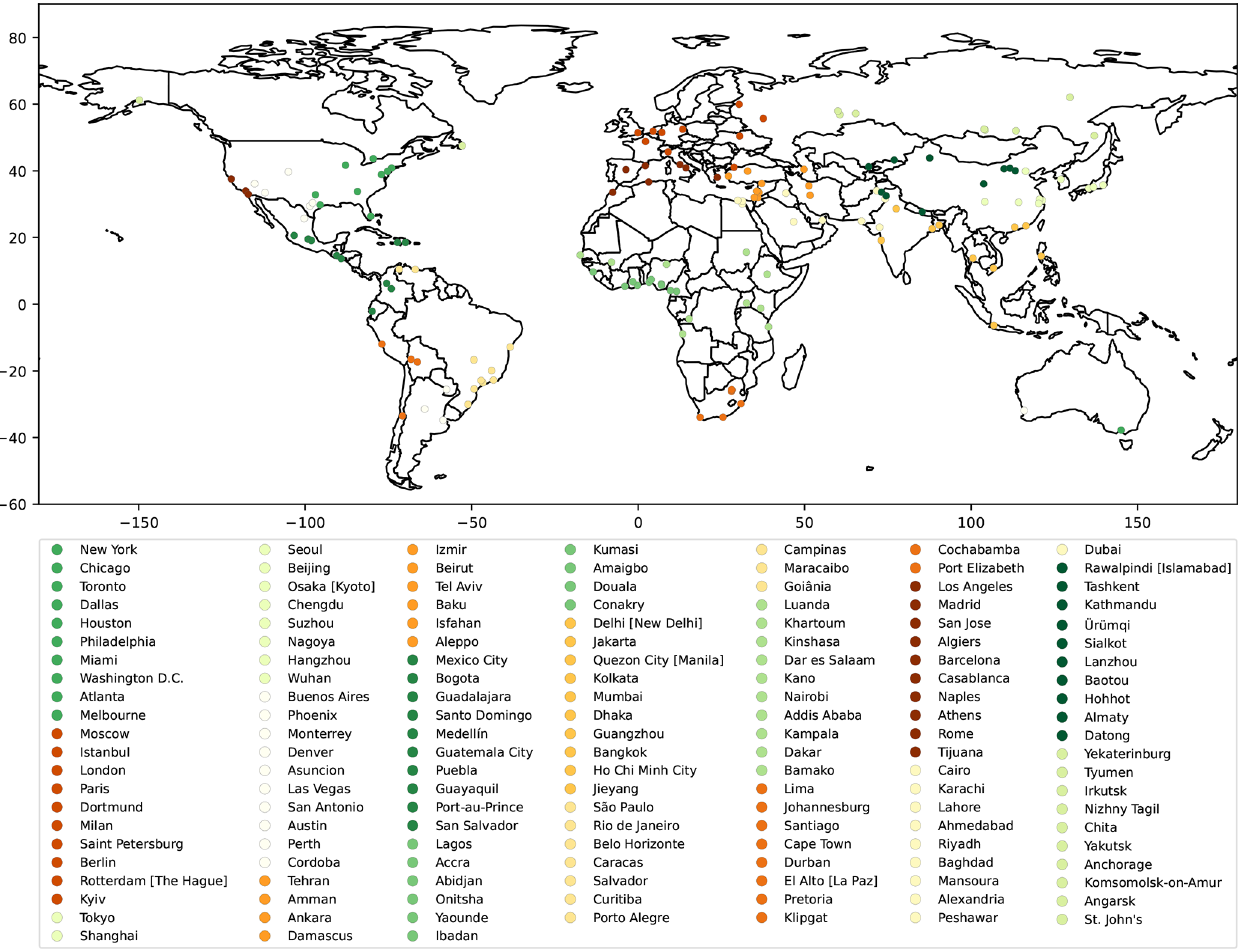
Figure C1. Spatial distribution of the 10 most populated functional urban areas per urban ecoregion. Note that ER colours are adopted from Schneider et al.